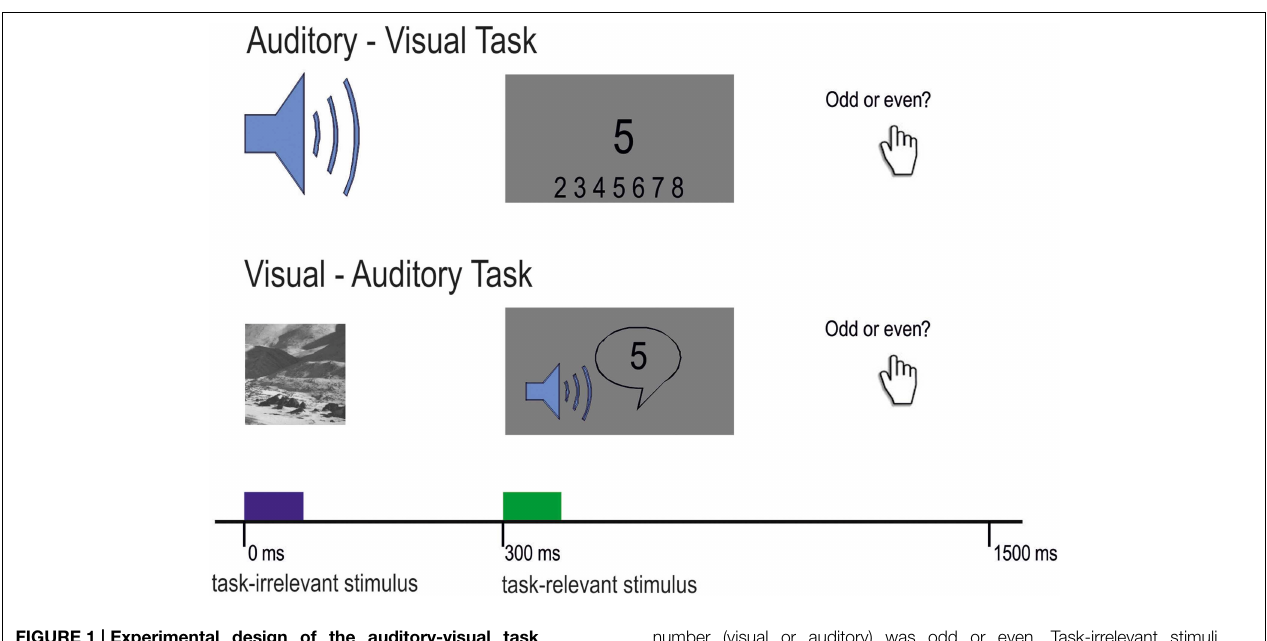
FIGURE 1 | Experimental design of the auditory-visual task (upper part) and the visual-auditory task (lower part). Participants had to decide in both conditions whether the presented